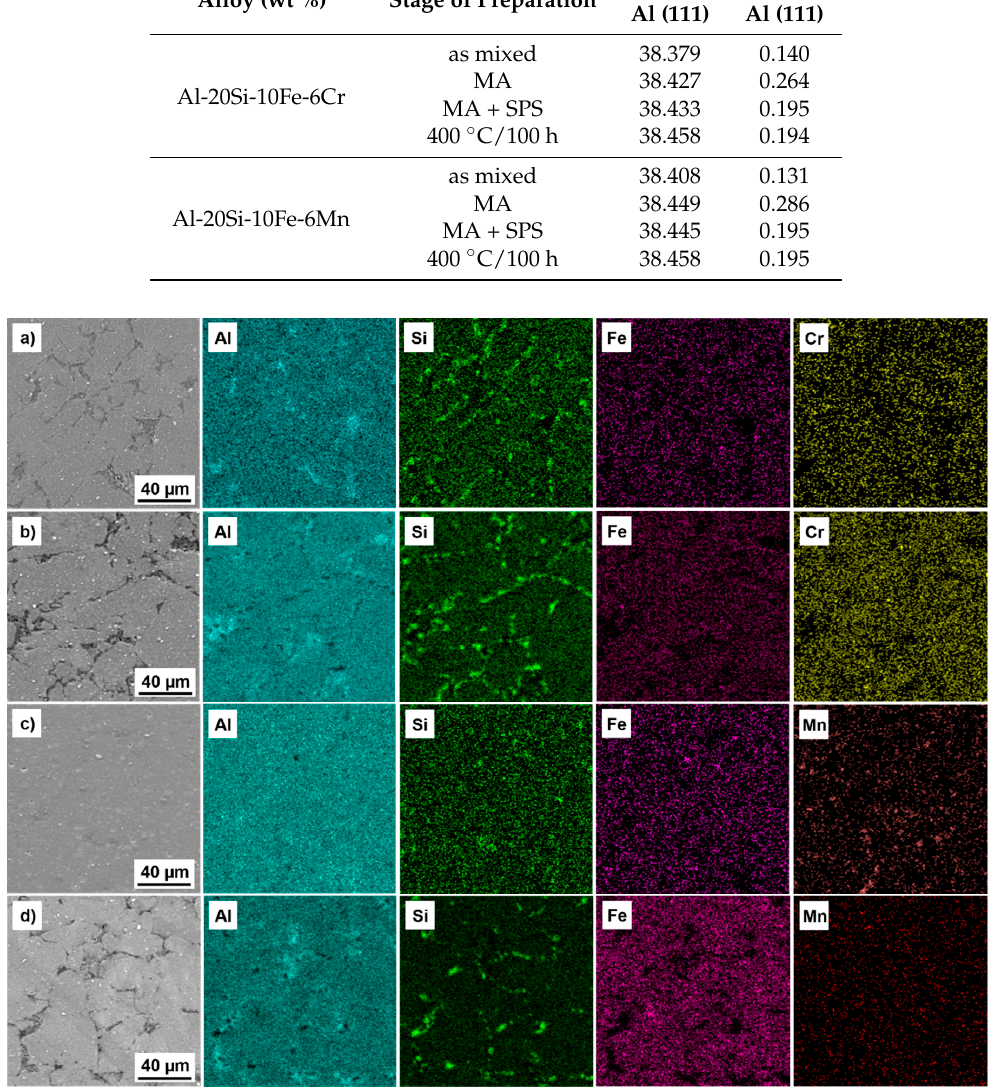
Figure 4. SEM + EDS maps of the: ( a , b ) Al-20Si-10Fe-6Cr; and ( c , d ) Al-20Si-10Fe-6Mn alloys. ( a , c ) Compact samples prepared by the combination of MA + SPS; and ( b , d ) the same materials after 100 h annealing at 400 °C.